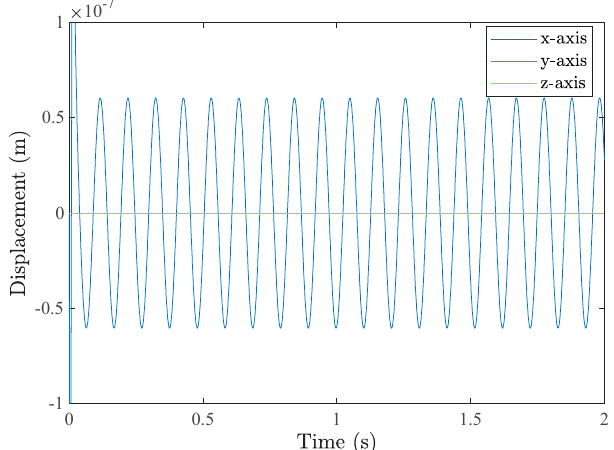
Figure 9. The time–domain response to the disturbance along the x -axis.